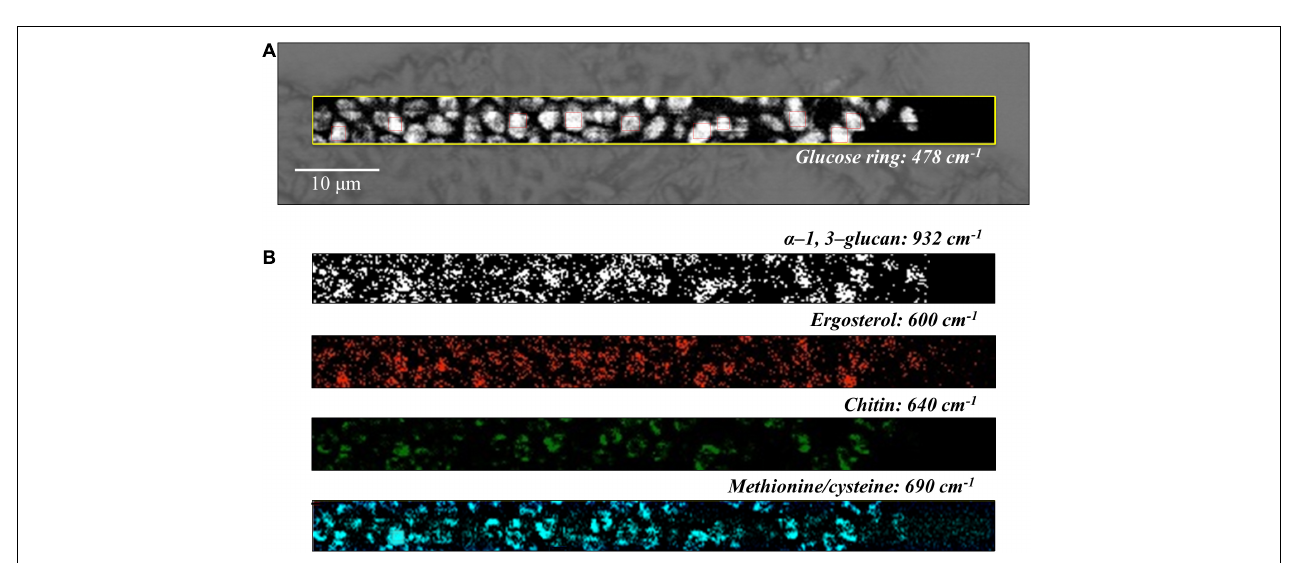
FIGURE 7 | (A) Optical micrograph and Raman map of glucose rings in membrane polysaccharides at 478 cm − 1 (in the yellow square region) of C. auris (Clade II) culture; in (B) from top to bottom (cf. labels), α -1, 3-glucans at 932 cm − 1 (white spots on black background), ergosterol at 600 cm − 1 , chitin at 640 cm − 1 , and S-containing amino acids at 690 cm − 1 . The maps in (B) correspond to the same square region in (A) . The 10 smaller square areas located in (A) represent the regions used for PCA analyses.